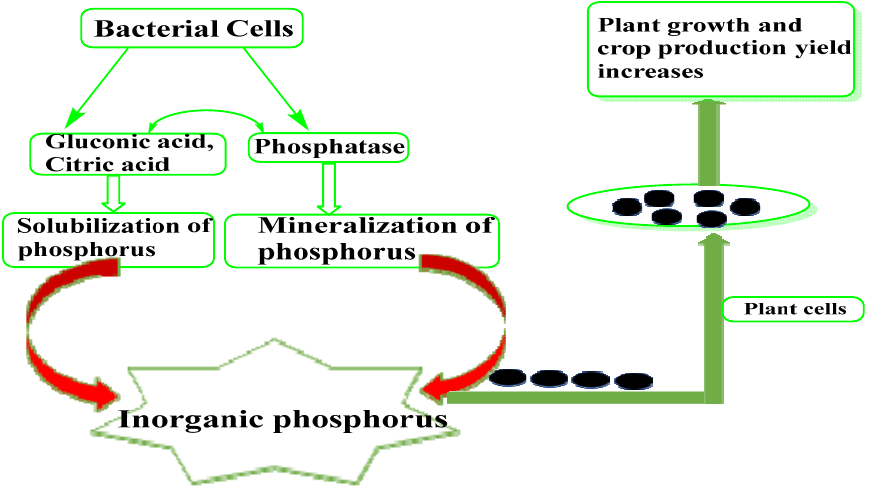
Figure 3. Phosphate-solubilizing rhizobacteria solubilize inorganic phosphorus. Inorganic phospho- rus is solubilized by bacteria using organic acids with a low molecular weight such as gluconic and citric acids. These acids’ hydroxyl (OH) and carboxyl (COOH) groups chelate the phosphate-bound cations, converting insoluble phosphorus into a soluble organic form. Mineralization of soluble phosphorus is accomplished through the production of several phosphatases, which catalyze the hydrolysis process. When plants absorb these solubilized and mineralized phosphorus molecules, their overall growth and crop output improve dramatically